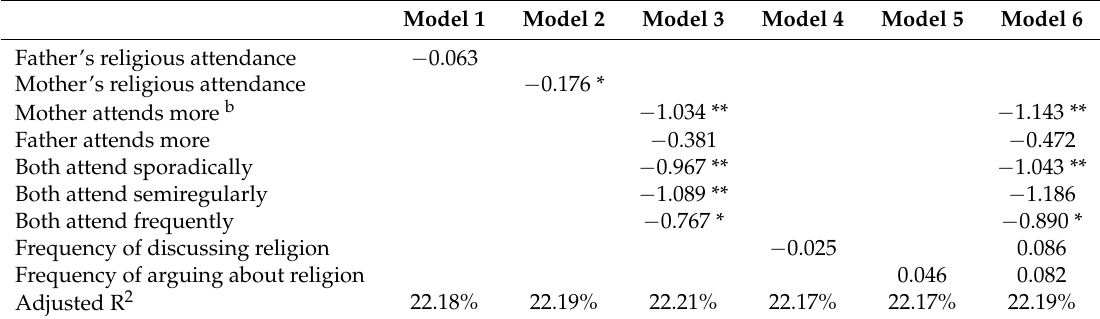
Table 8. Unstandardized coefficients predicting children’s standardized math test scores (n = 10,720) a .